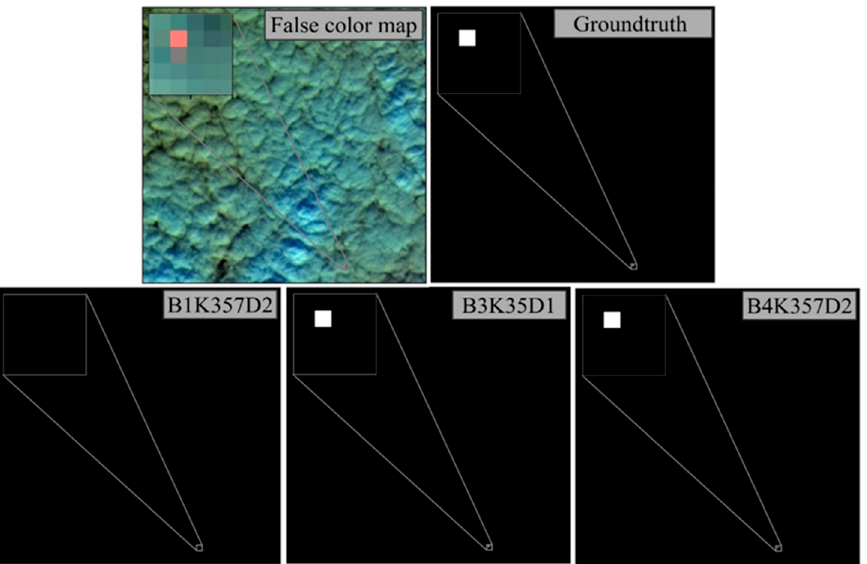
Figure 10. Qualitative comparison between the three best models for AFD in severe cloudy scenes and few fire pixels.